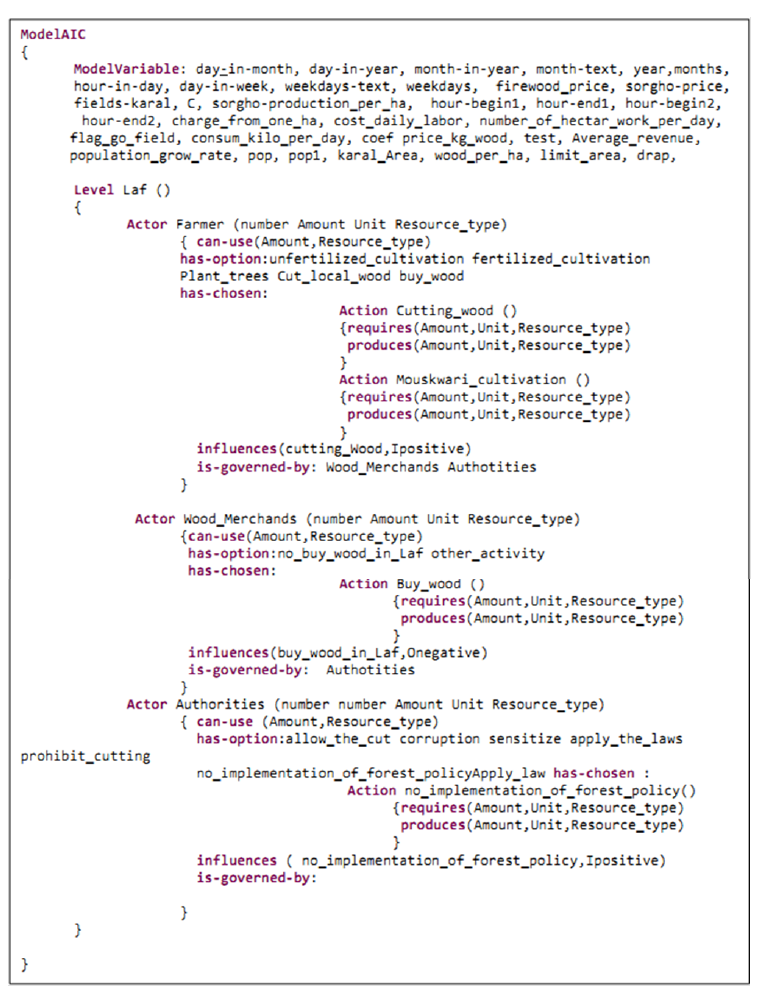
Figure 10. Model of Laf Forest Reserve deforestation process obtained from the developed language domain